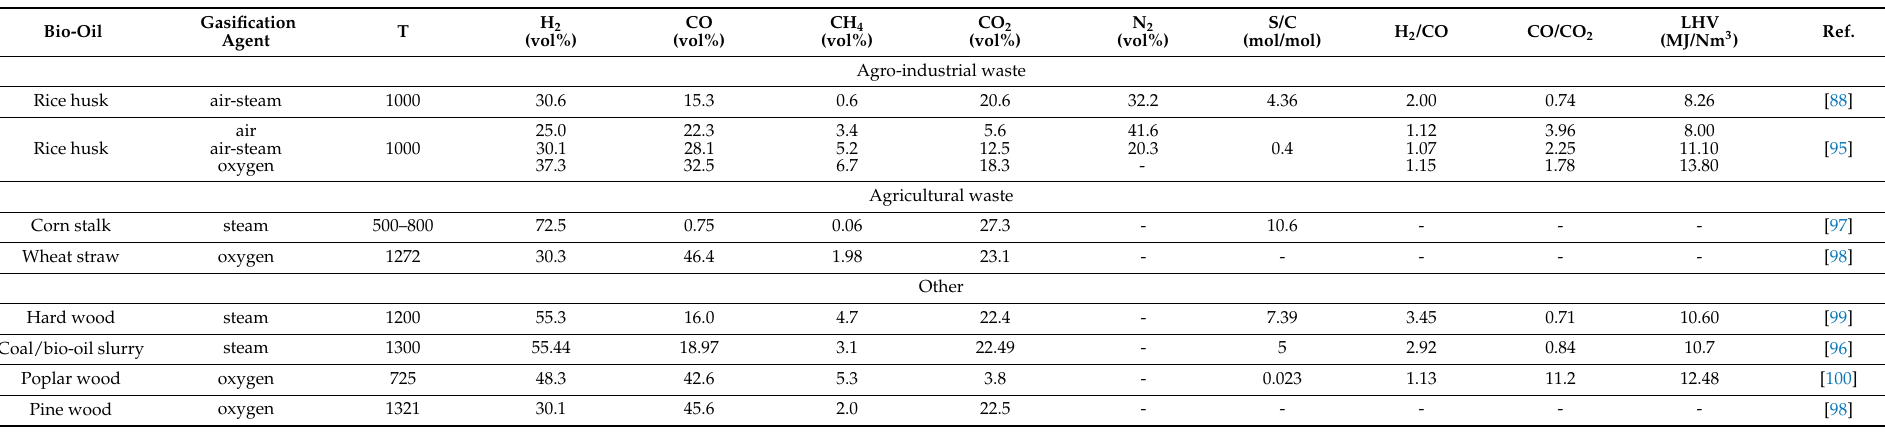
Table 11. Effect of bio-oil gasification parameters on the composition of the produced